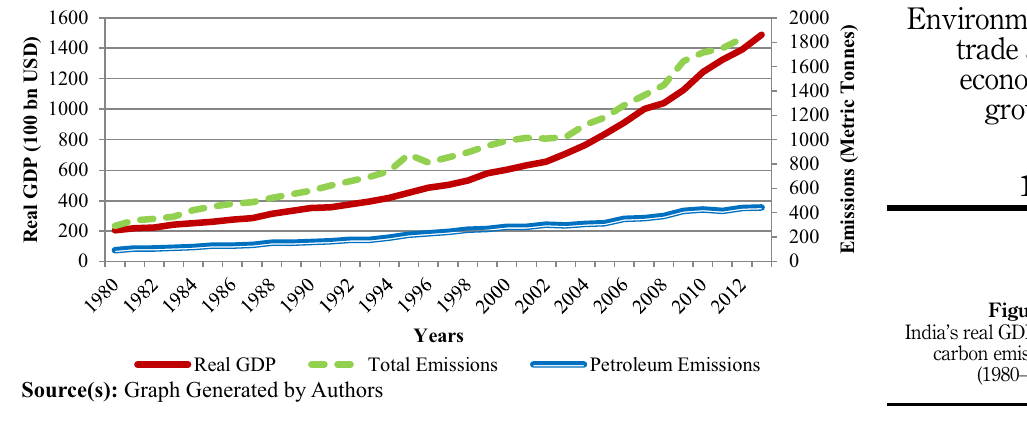
Figure 2. India ’ s real GDP and carbon emissions (1980 –